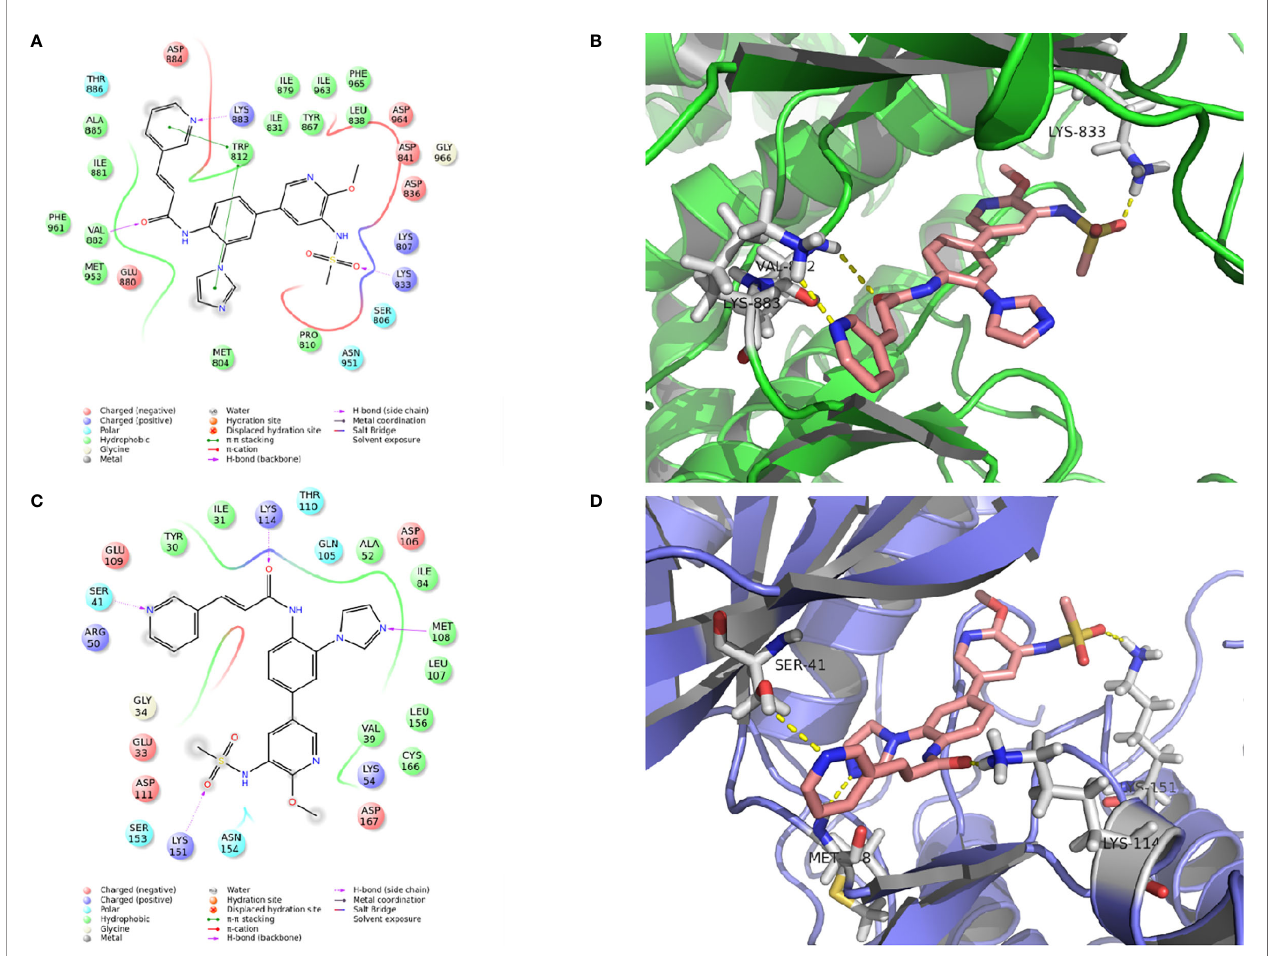
FIGURE 4 | The molecular docking of CK-3 with PI3K or ERK. (A, C) A two-dimensional interaction diagram of CK-3 on the catalytic cavity of PI3K (PDB code: 3DBS) and ERK (PDB code: 5K4I). (B, D) A three-dimensional interaction diagram of CK-3 on the catalytic cavity of PI3K and ERK. The crystal structures of proteins are depicted as green and purple cartoons, and key amino acids are depicted as gray sticks. CK-3 is shown as pink sticks. Hydrogen bonds are represented by yellow dotted